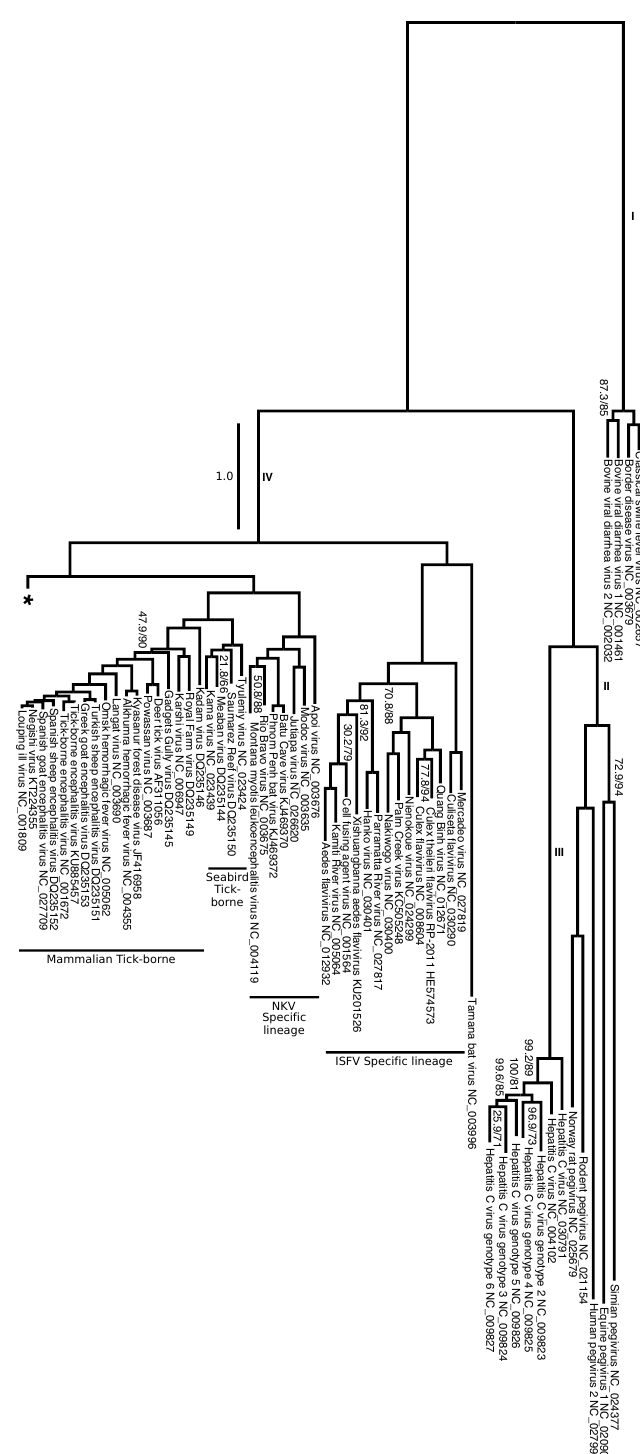
Figure 8. Phylogenetic hypothesis (tree No. 0 in Table 1). Branch lengths represent an estimation of the average number of nucleotide substitutions per site. Node labels indicate SH-aLRT support/ultrafast bootstrap (only shown if one of the values is below 90%). Clade names correlate to the character categorization analysis (Table S2, Supplementary Materials). Branch labels represent the four genera: I = Pestivirus ; II = Pegivirus ; III = Hepacivirus ; IV = Flavivirus . Tree continues on Figure 8 (indicated by *). See Figure S2 (Supplementary Materials) for a full version of this